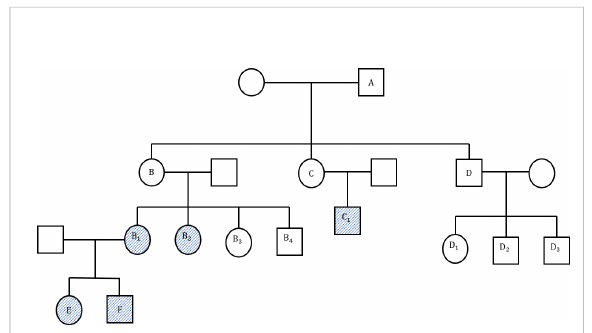
lynch syndrome (LS) gene. B: Rectal cancer at 33 years, uterine cancer at 50 years, pancreatic cancer at 78 years, not tested. B1: hMSH2, colon cancer at 34 years. B2: MLH, PMS2, endometrial cancer and intraductal pancreatic neoplasia at 62 years. B3: LS gene negative. B4: LS gene negative. C: Renal cancer in 30s, not tested. C1: Bowel and kidney cancer at 30 years, LS gene positive. D: Bowel and liver cancer at 75 years. D1: LS gene negative. D2: LS gene negative. D3: LS gene negative. E: MSH2, Colon cancer at 32 years (Index patient). F: MSH2.